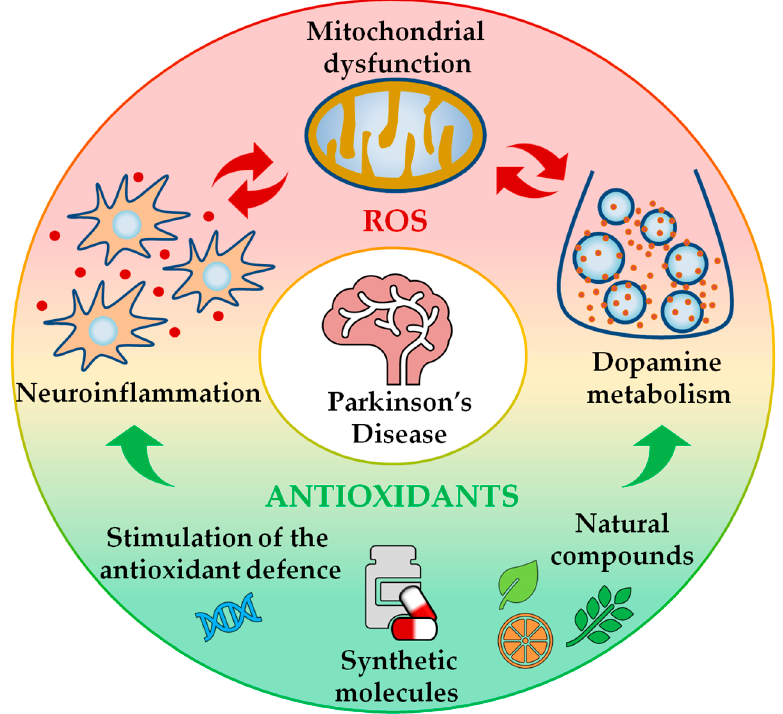
Figure 1. Beneficial effects of antioxidant treatment on the maintenance of redox homeostasis in Parkinson’s disease (PD). PD pathology is associated with an unbalanced redox state, which is the result of mitochondrial dysfunction, neuroinflammation and dopamine metabolism. Antioxidant therapies can help to hinder excessive oxidative stress conditions by buffering reactive oxygen species (ROS) production and limiting ROS-related damage. Antioxidant treatments encompass both natural (e.g., vitamins and plant extracts) and synthetic compounds (e.g., superoxide dismutase-mimetics), and can promote the stimulation of the endogenous antioxidant defence system. Therefore, the antioxidant treatment can act as a co-adjuvant to currently used PD therapies.